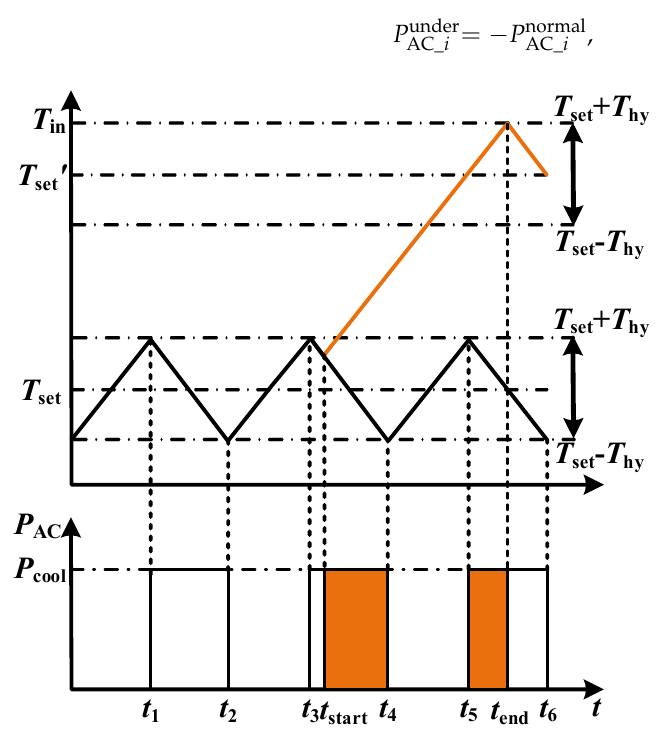
Figure 4. The operating performances of the AC for under-voltage.